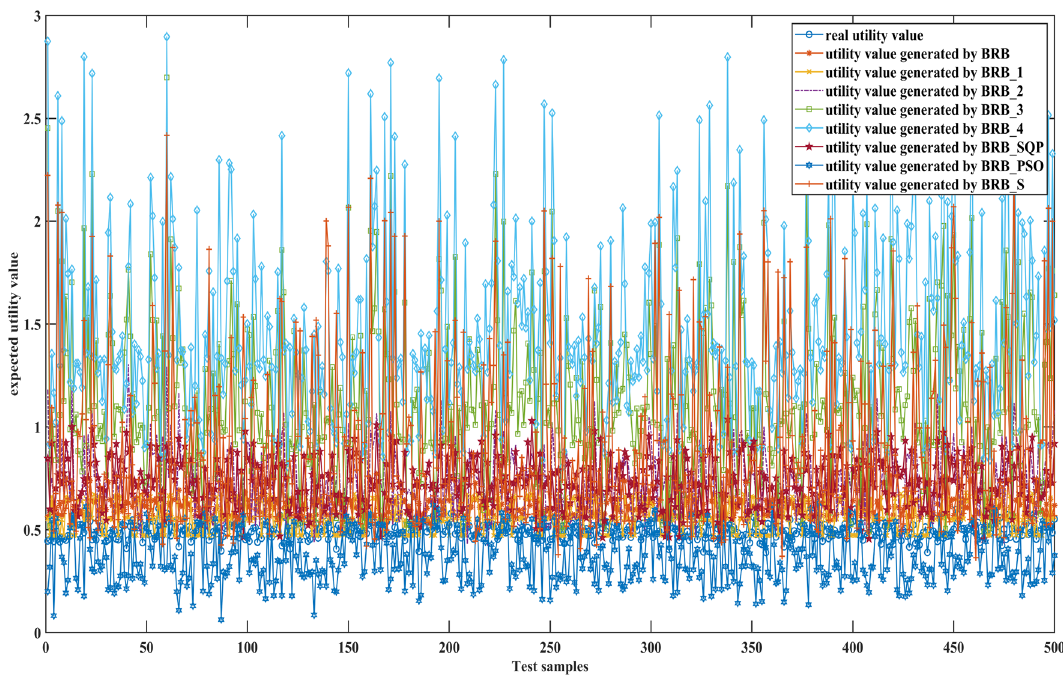
Figure 6. The 1–500 comparative results generated by different